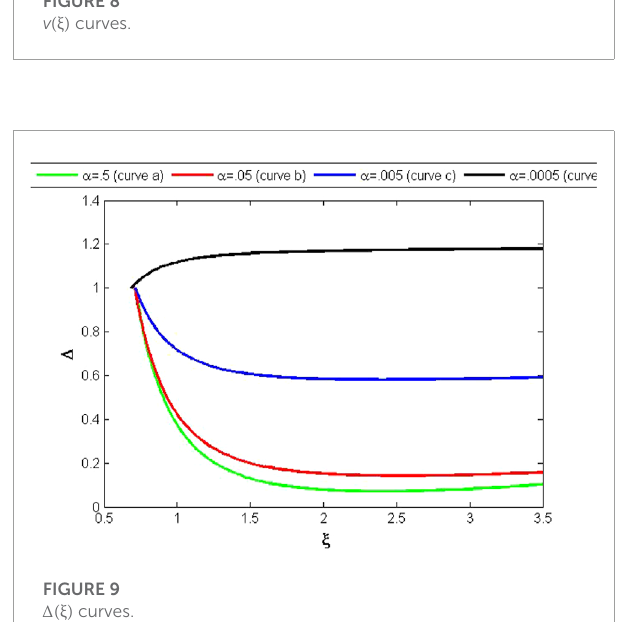
FIGURE 8 v ( ξ ) curves.